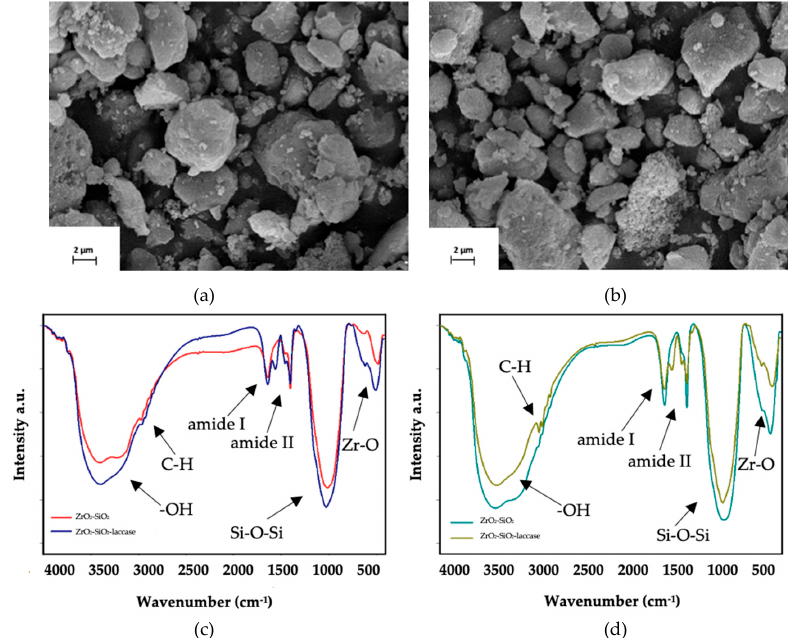
Figure 3. Scanning electron microscope (SEM) images of: ( a ) ZrO 2 –SiO 2 and ( b ) ZrO 2 –SiO 2 /Cu 2+ and FTIR spectra of: ( c ) ZrO 2 –SiO 2 , ZrO 2 –SiO 2 –laccase and ( d ) ZrO 2 –SiO 2 /Cu 2+ and ZrO 2 –SiO 2 /Cu 2+ –laccase systems.